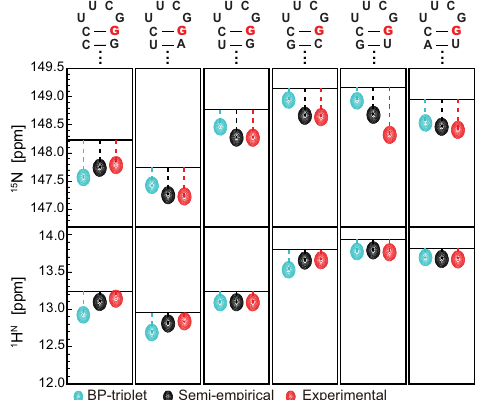
Fig. 5 Comparison of 15 N (upper panel) and 1 H N (lower panel) chemical shifts for the guanine in the CG closing base pair of UUCG tetraloops. The secondary structures of UUCG motifs are shown on top of each panel, and the guanine of interest is highlighted in red. The horizontal line in each subplot marks the sum of chemical shift contributions from the central CG base pair and the base pair immediately below it. Resonances colored in cyan and black represent the total chemical shifts of the highlighted guanine by including the contribution from UUCG tetraloop through two approaches: prediction using the BP-triplet table (cyan); RC shift calculation using the calibrated parameter set (black). The resonances colored in red represent experimental